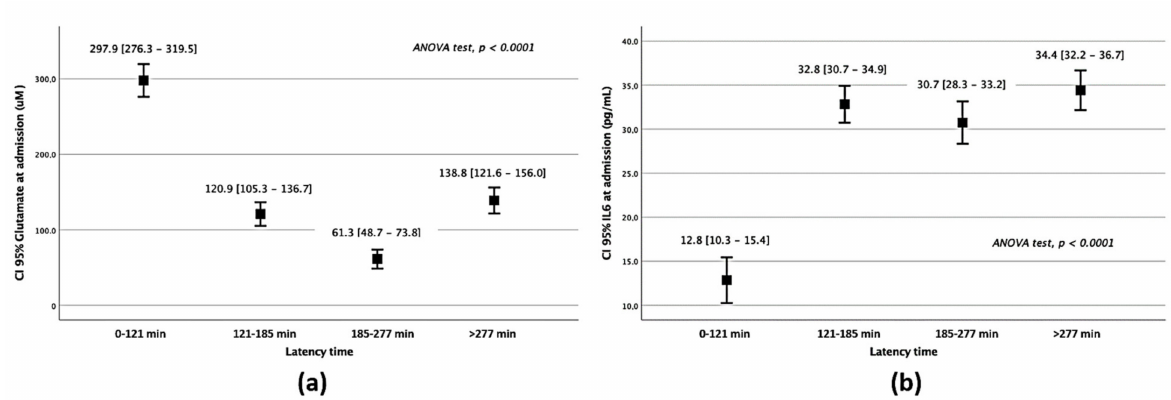
Figure 1. Serum marker analysis of patients belonging to different latency times. Glutamate ( a ) and IL–6 ( b ) serum levels on admission regarding the latency times of attendance.